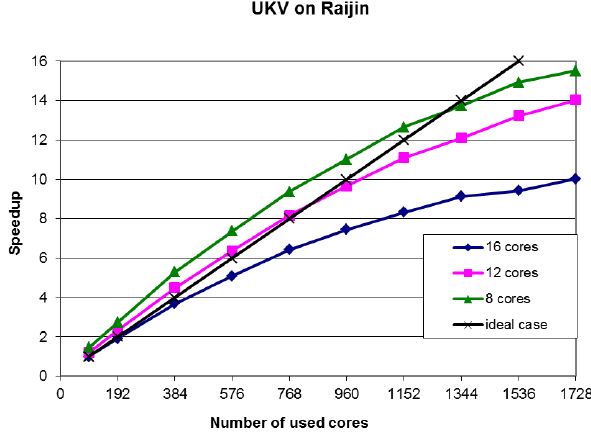
Figure 3. Speedup as a function of number of used cores on Raijin. Speedup was calculated in relation to the elapsed time of 9523s obtained for a 96-core run on fully committed nodes.